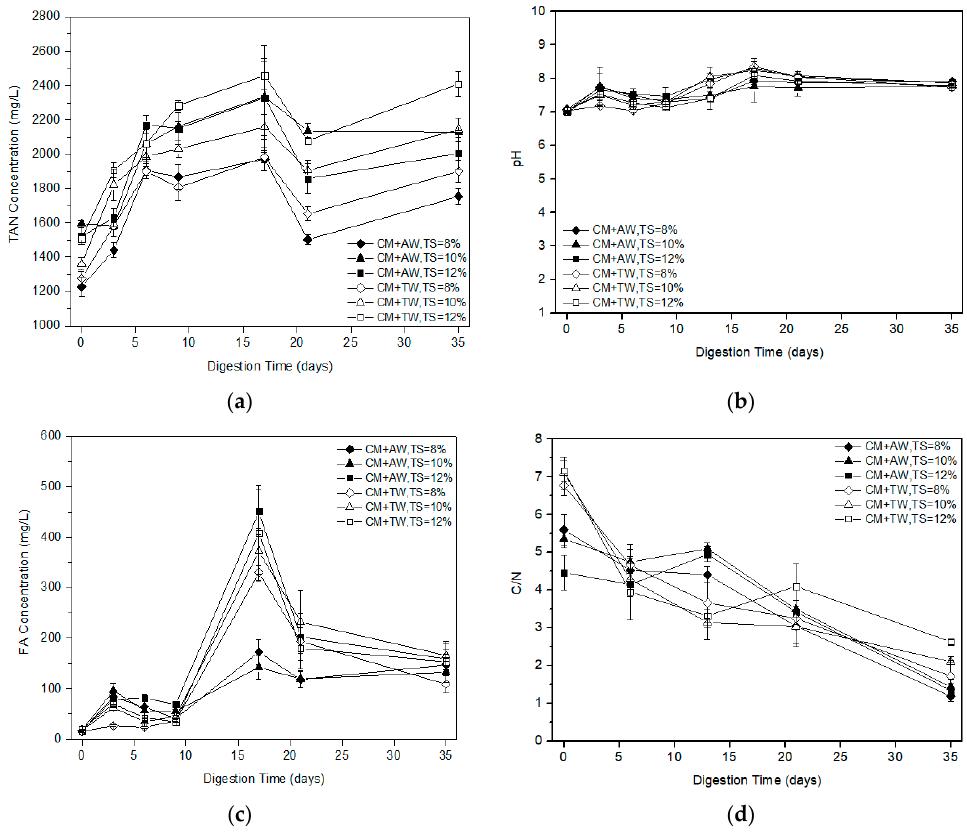
Figure 2. TAN ( a ), pH ( b ), FA ( c ), and C/N ( d ) profile with digestion time for diluted CM.